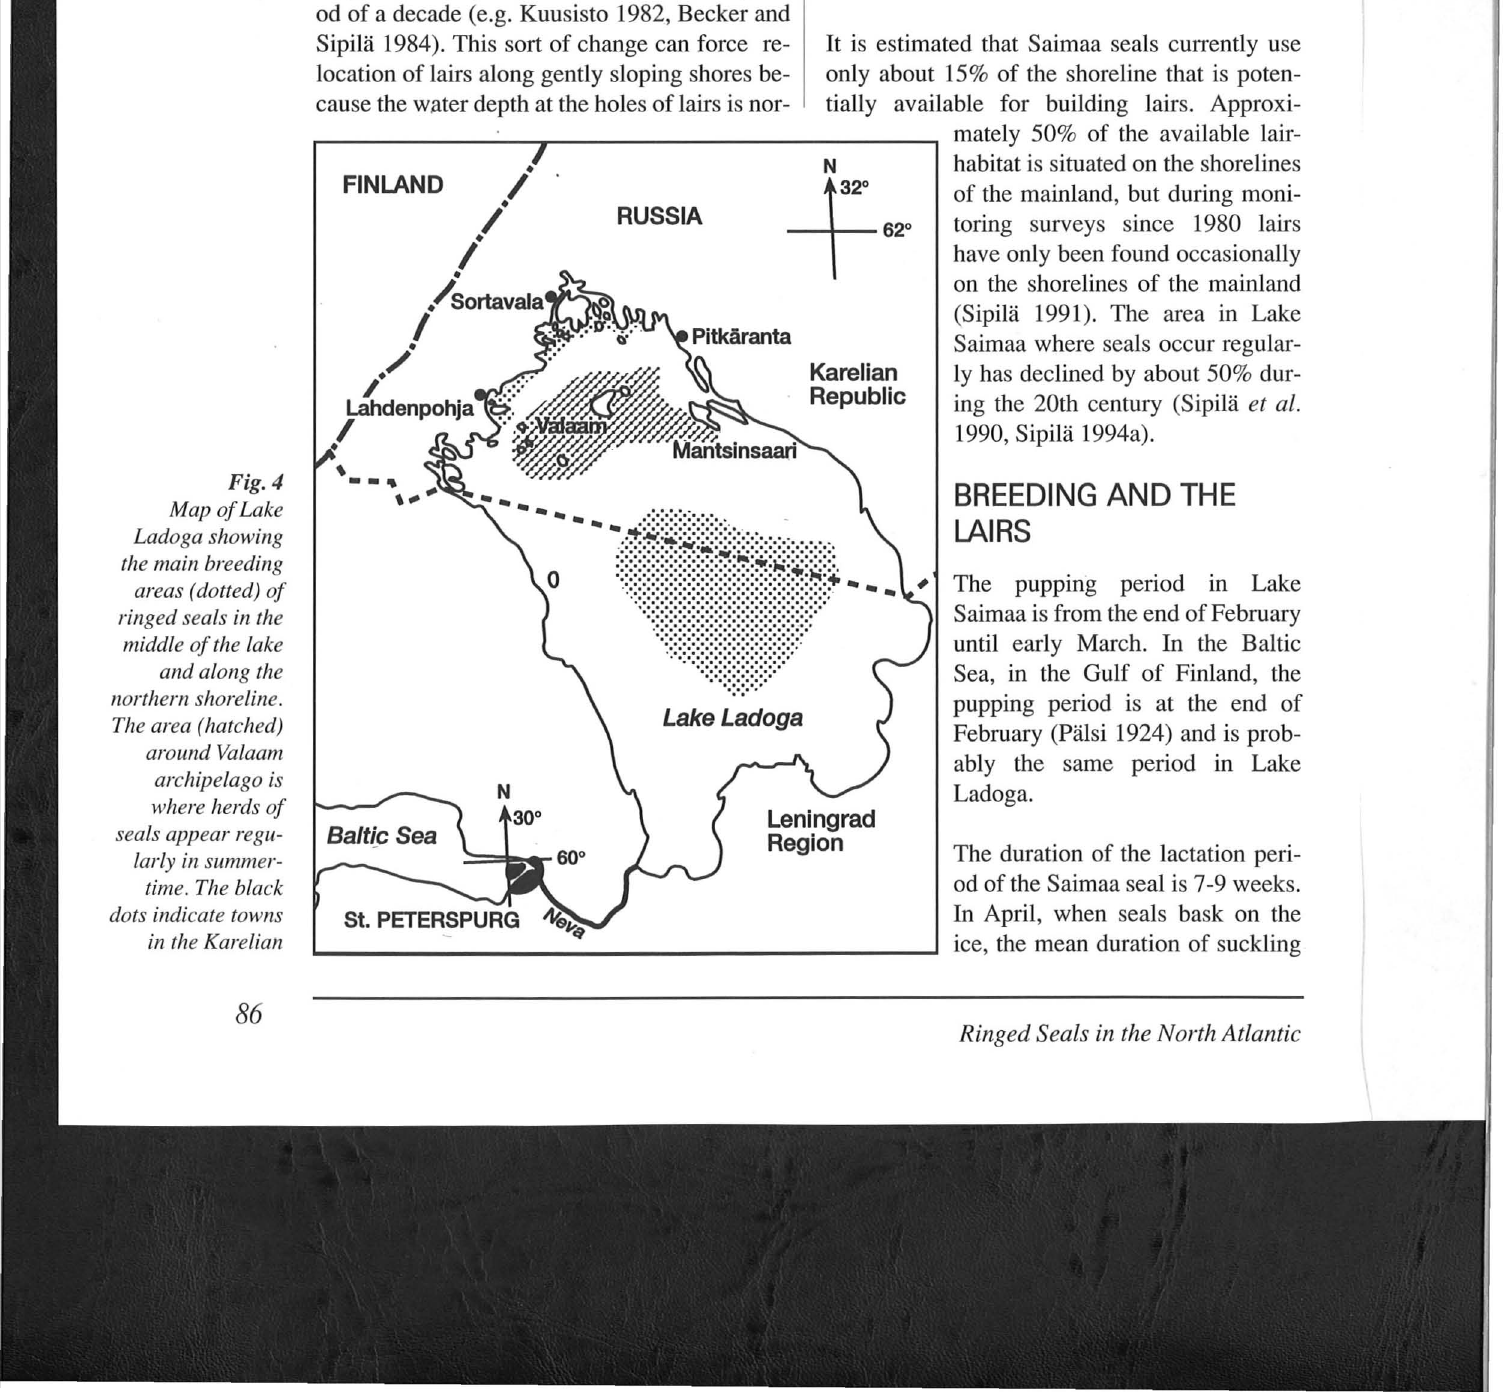
Map of Lake Ladoga showing the main breeding areas (dotted) of ringed seals in the middle of the lake and along the northern shoreline. The area (hatched) around Valaam archipelago is where herds of seals appear regu larly in summer time. The black dots indicate